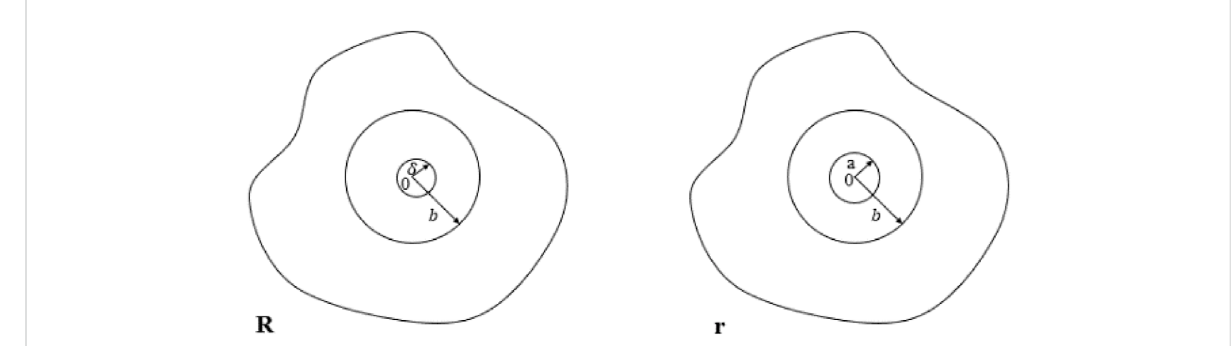
FIGURE 2 Schematic diagram of coordinate transformation of two-dimensional annular